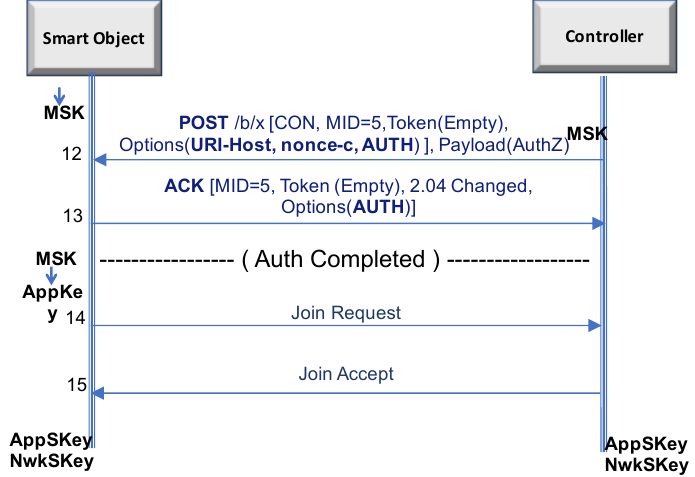
Figure 2. LoRaWAN security association establishment after LO-CoAP-EAP